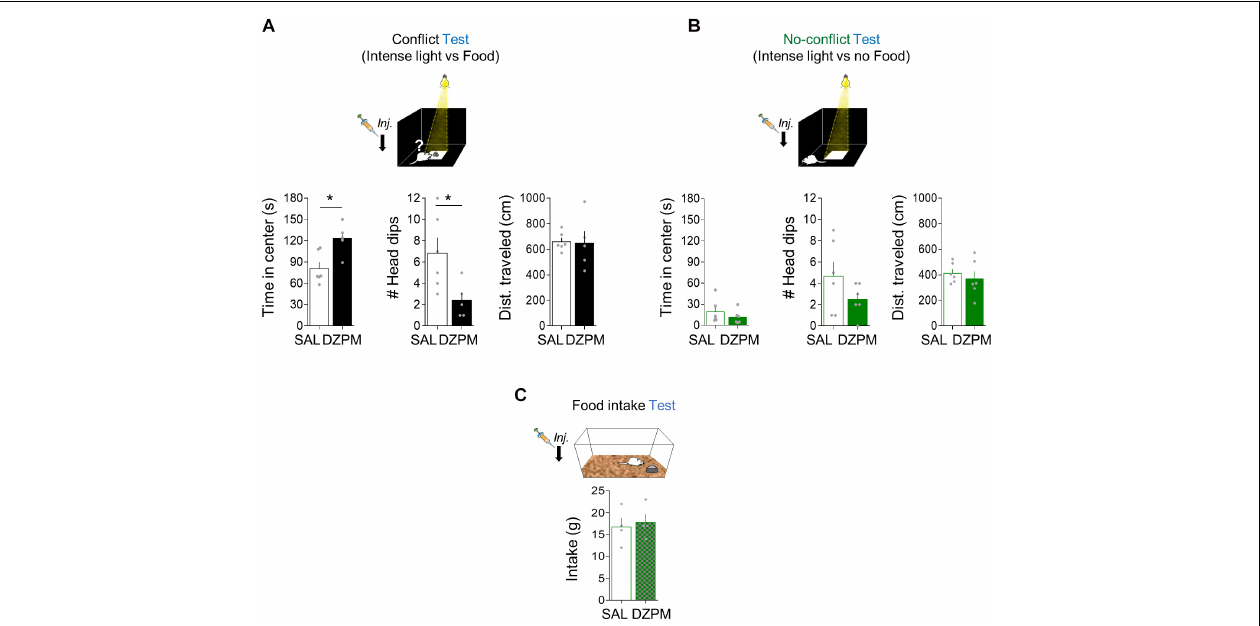
FIGURE 4 | Diazepam increases risky foraging while decreasing head dips during conflict without affecting no-conflict behaviors. Rats placed in an open field arena were tested for innate exploratory behaviors (foraging), head dips (risk assessment), and general locomotion (distance traveled) mediated either by conflict or no-conflict conditions. (A) In the foraging-mediated innate conflict test, the diazepam-treated rats spent more time foraging for food (reward) in the brightly illuminated center of the arena (threat zone) while showing low number of head dips events and similar distance traveled in the open field, as compared to the saline group (SAL, n = 6; DZMP, n = 5). (B) In the foraging test where there is no food available (no reward) at the center of the arena (no conflict), time in the brightly illuminated center, head-dip events, and distance traveled were similar in SAL and DZPM groups (SAL, n = 6; DZPM, n = 6). (C) Rats in their home cages showed similar food intake levels after SAL and diazepam injection (SAL, n = 4; DZPM, n = 4) during the food intake test. Error bars indicate SEM. * p <